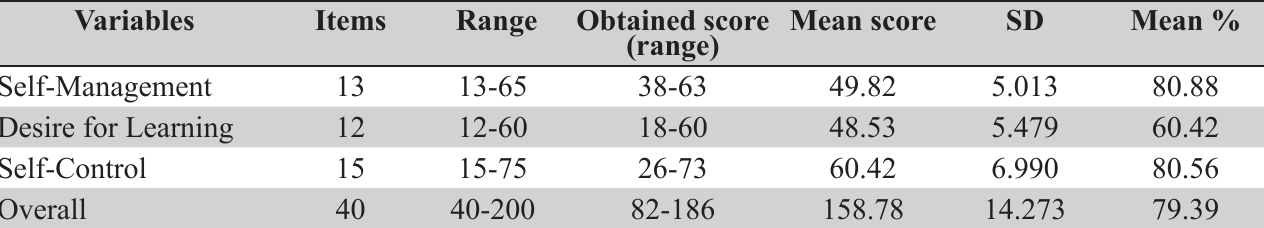
Table 3: Mean Score obtained by Participants in Subscale of SDLR (N=147).